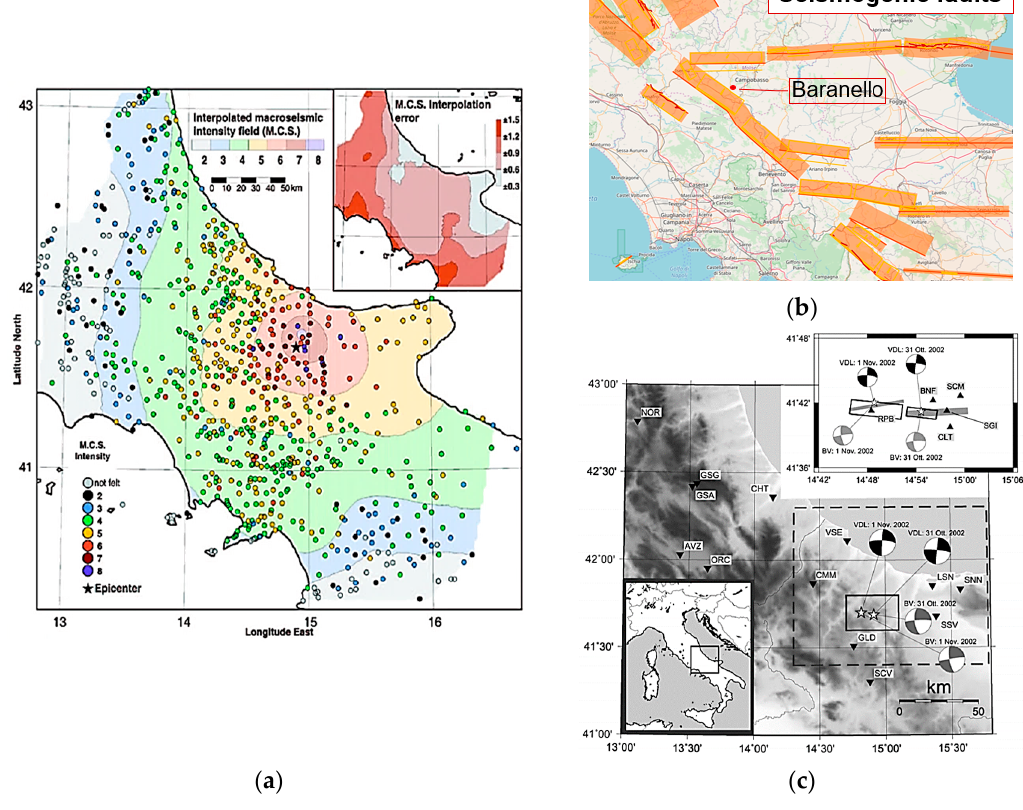
Figure 4. Macroseismic intensities ( a ), seismogenic-faults distribution in the study area ( b ) and focal mechanisms of the fault model ( c ).